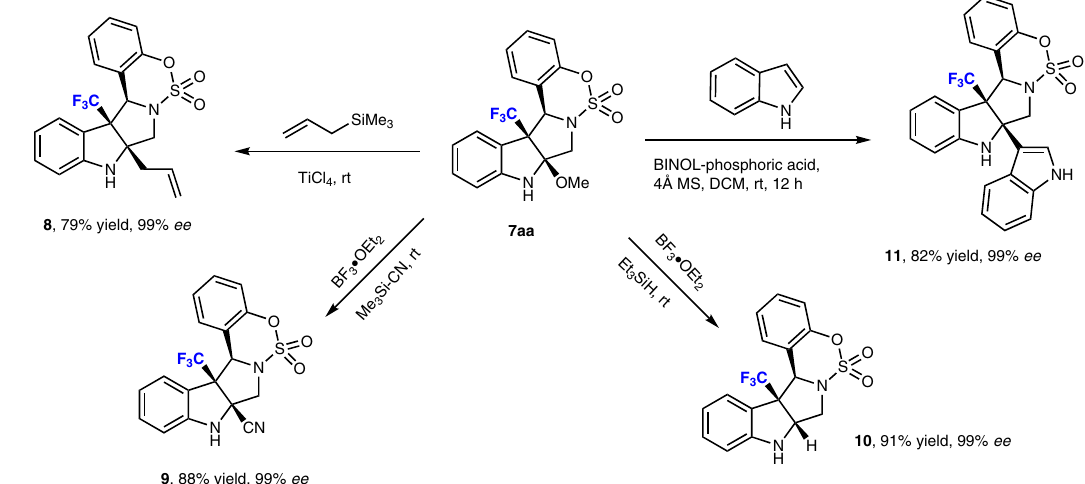
Fig. 5 Synthetic utility II. Examples of Lewis-acid-mediated functionalization reactions of